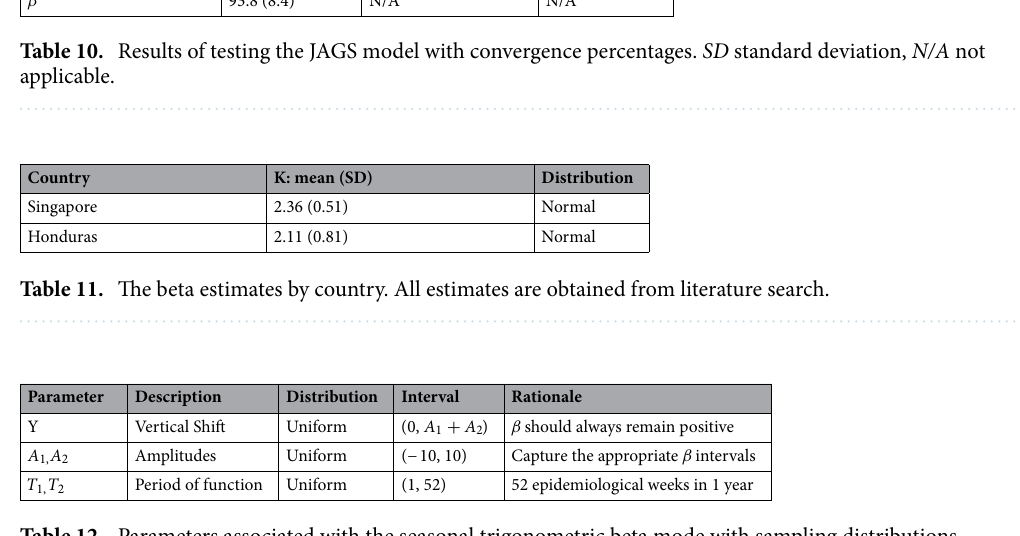
Table 12. Parameters associated with the seasonal trigonometric beta mode with sampling